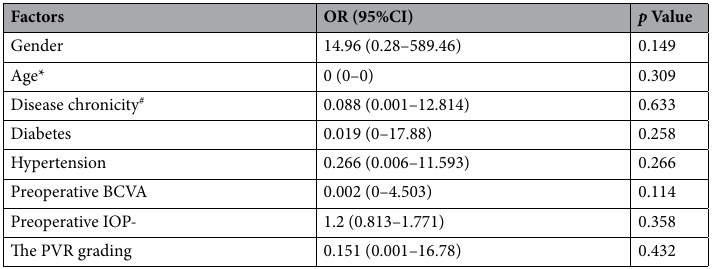
Table 5. Binary logistic regression of risk factors for persistent SRF at postoperative 24 weeks. Age*: Level 1, below 30 yrs; Level 2, above 30 yrs and below 60 yrs; Level 3, above 60 yrs. Disease chronicity # : Acute: symptom duration < = 7 days; Subacute: symptom duration > 7 days and < = 30 days; Chronic: symptom duration > 30 days. OR, odd ration; CI, confidence